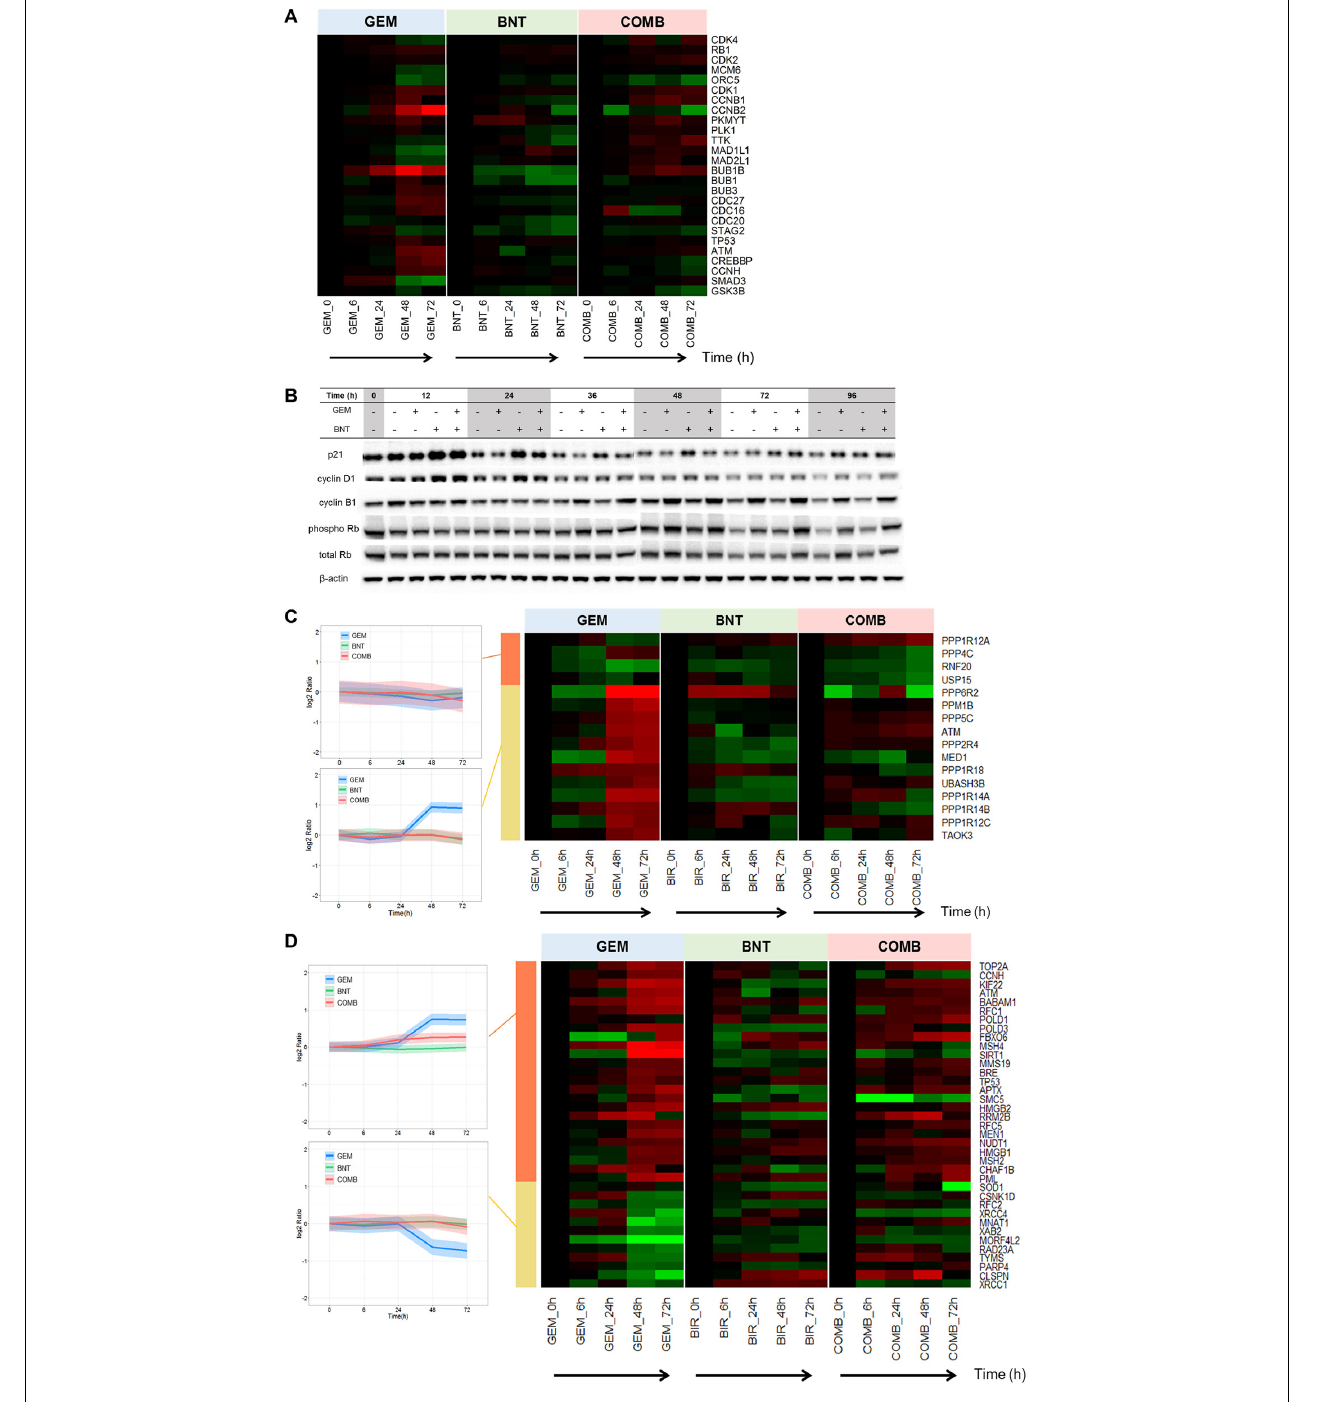
FIGURE 3 | Pathways regulating cell cycle progression, DNA damage responses, and DNA repair affected by gemcitabine/birinapant treatment. (A) Heat map representing the time-dependent changes in the abundance of specific proteins related to cell cycle regulation. (B) Western blot validation of key cell cycle regulation proteins. Heat map representing the time course and magnitude of change in proteins related to (C) regulation of DNA damage responses by the phosphatase and ubiquitin-proteasome system, and (D) DNA repair. Proteins in (C,D) were further clustered according to different temporal patterns in response to gemcitabine vs. the combined drugs by k-means clustering in R Bioconductor. In the heat map plots, red indicates up-regulation and green indicates down-regulation. The intensity of the color reflects the fold-change of the protein. The western blots (B) for 0, 12, 24, and 36 h were from one membrane, and the blots from 0, 48, 72, and 96 h were from a second membrane; the intensity of the blot images was adjusted so that the bands from the two membranes for time 0 h and the loading controls were the same intensity. The proteins relevant to each gene name in the heat map are summarized in Supplementary Table S1.